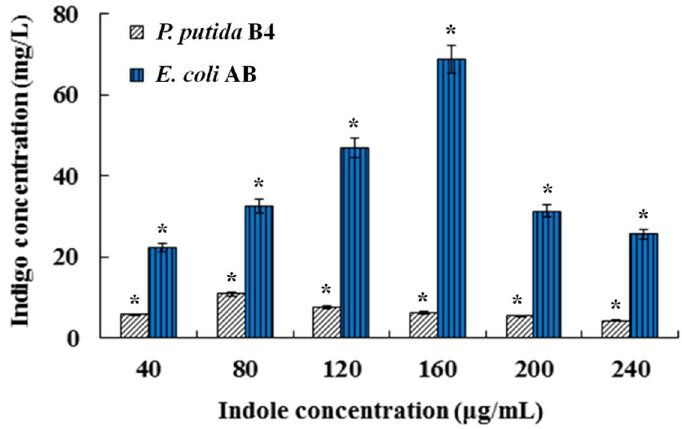
Figure 1. Indigo biosynthesis from different concentrations of indole in fermentation of P. putida B4 and E. coli AB. Bars with asterisk (*) are significantly different ( p < 0.05). In order to avoid the cytotoxicity of indole, tryptophan was used as the substrate of indigo biosynthesis. As shown in Figure 2, much more indigo was produced from trypto- phan than that from indole in E. coli AB. The maximum yield of indigo from 1.0 mg/mL of tryptophan in E. coli AB was determined to be about 380 mg/L after 24 h of fermentation (Figure 3), which was about 5.4-fold higher than the highest yield (70 mg/L) from 160 μg/mL of indole, revealing that tryptophan was more suitable than indole as the substrate for indigo production by E. coli fermentation.